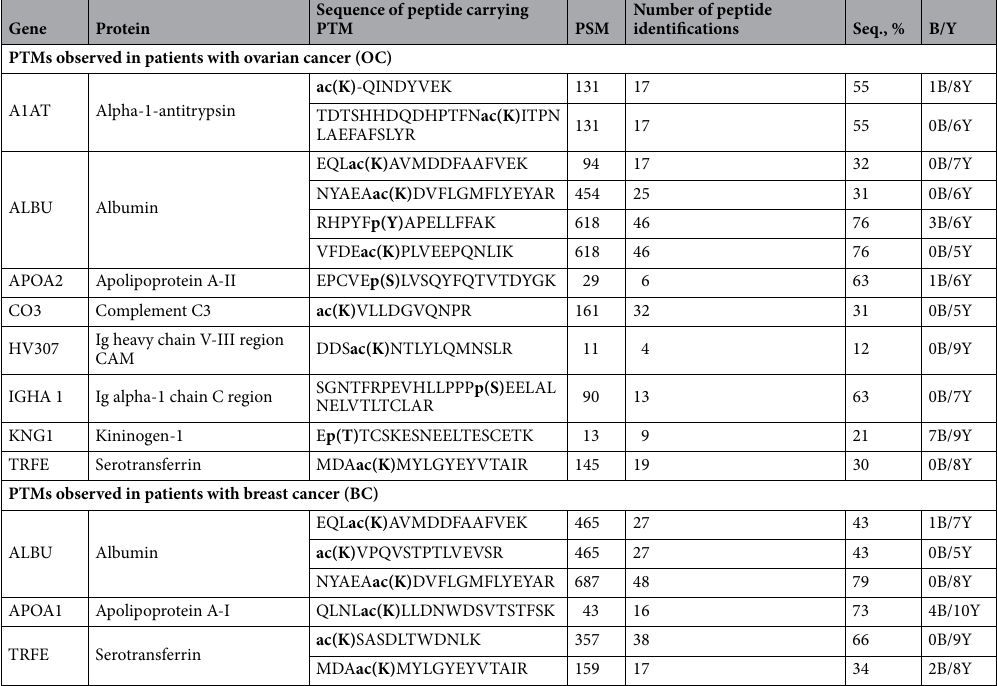
Table 1. The list of proteins carrying the defined PTMs and found specifically in patients with ovarian cancer or patients with breast cancer. Bold values indicate the exact affected (modified) amino acid residue to attract readers’ attentionand for easier navigation. Peptides are listed with the main accompanying mass-spectrometric characterizations: PSM—peptide spectra match (is the number of spectra matching the theoretical peptide sequence with high score); b- and y-type of fragment ions are C- and N-terminal sequential fragment ions populated after peptide (precursor ion) decay. Complete results are available in the Supplemental Materials Table S2. Ac(K) acetylation of lysine; p(Y), p(T), p(S) phosphorylation of tyrosine, threonine and serine, correspondingly; PSM peptide spectra; Seq., % amino acids coverage for the identified peptides; b/y the number of revealed and attained b- and y-type fragment